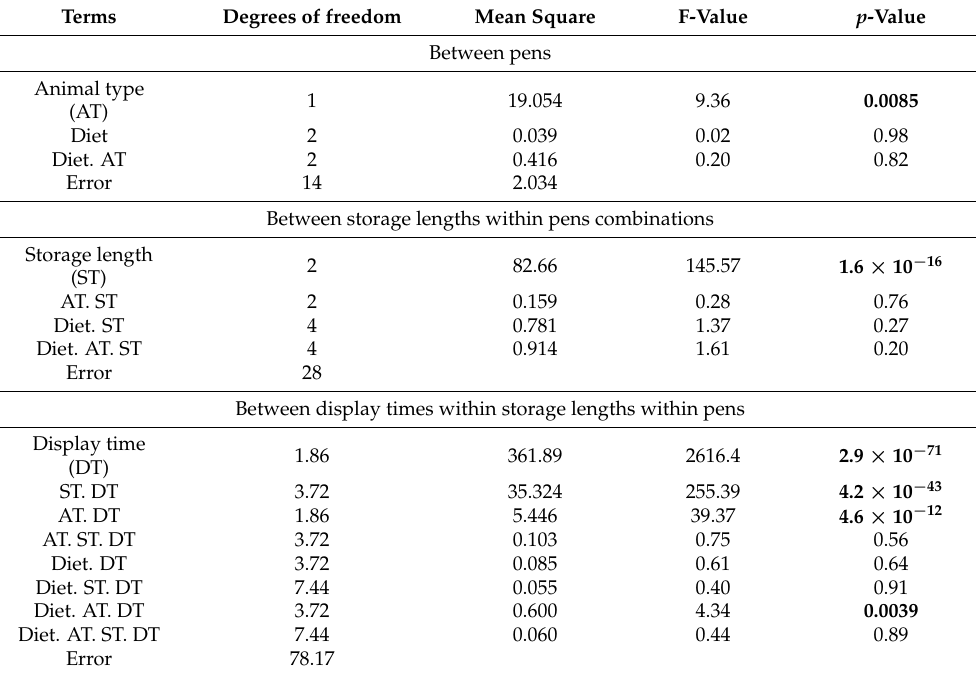
Table 3. Repeated measures analysis of variance for the redness (a*-value) of muscle longissimus lumborum displayed for 72 h under simulated refrigeration conditions. Degrees of freedom are corrected by the Greenhouse–Geisser epsilon in the between display times stratum ( ε = 0.6204; p = 0.00002 for testing difference from